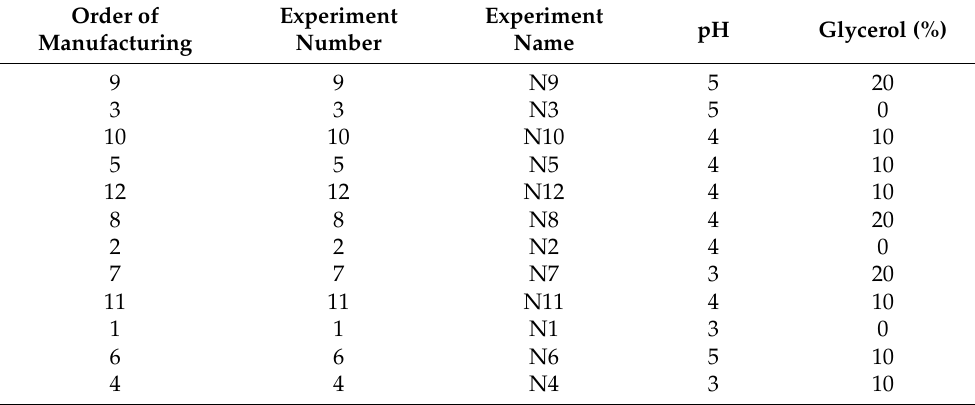
Table 5. Design of experiments for Propranolol 10 mg/mL. Name and order of experiments, pH to be set, and the amount of solubilizer (%). N5, N10–12 are replicates. Amount of sodium benzoate was